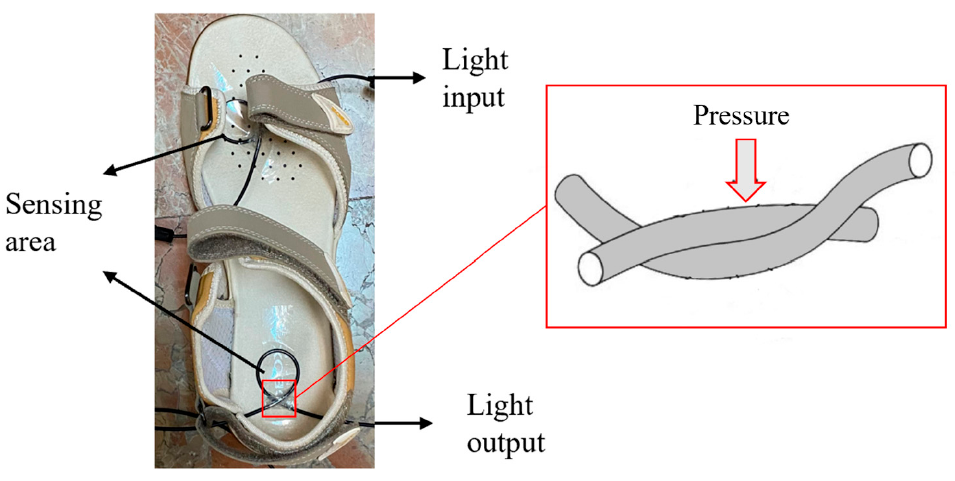
section in which the highest bending takes place.